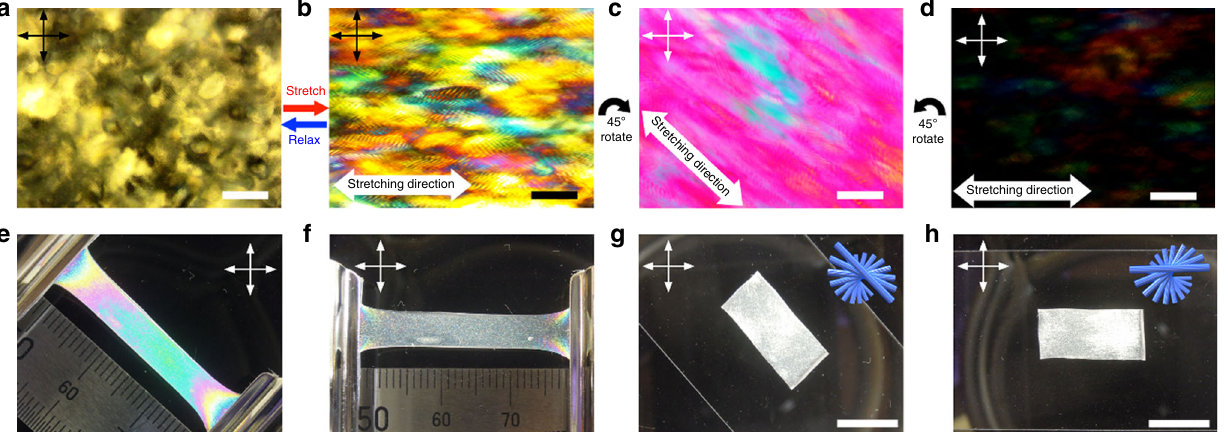
Fig. 2 Polarized light observation of CNC-E. a Fingerprint texture of unstretched CNC-E as viewed by POM. b Distorted fi ngerprints observed in stretched CNC-E by POM under prolonged exposure time for photography. c Stretched CNC-E viewed between crossed polarizers by POM. Stretching direction was arranged 45° to polarizers. d POM image of stretched CNC-E under same exposure time for photograph as c . Stretching direction was arranged 0° to polarizer. e , f Stretched CNC-E fi lm rotated between crossed polarizers. g , h Unstretched CNC-E fi lm rotated between crossed polarizers. (Arrows in each image indicate polarization axes of both polarizer and analyzer.) Scale bars represent a – d 100 µ m, and g , h 1